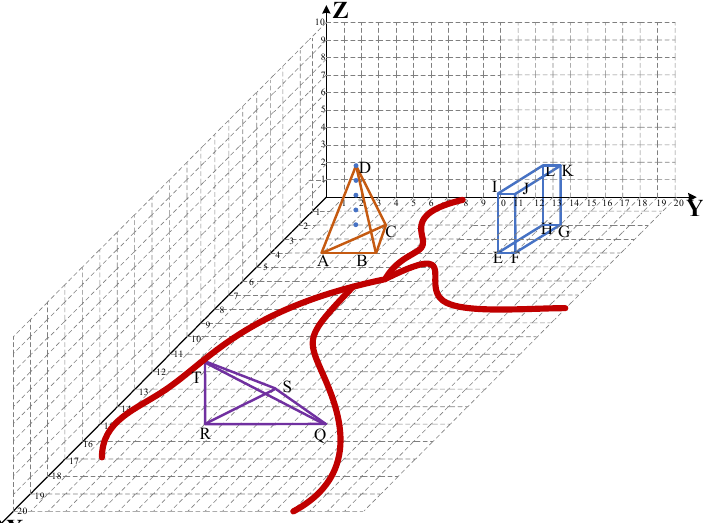
Figure 7. Sketch of VTS radar station environment. Table 1. Relevant information of